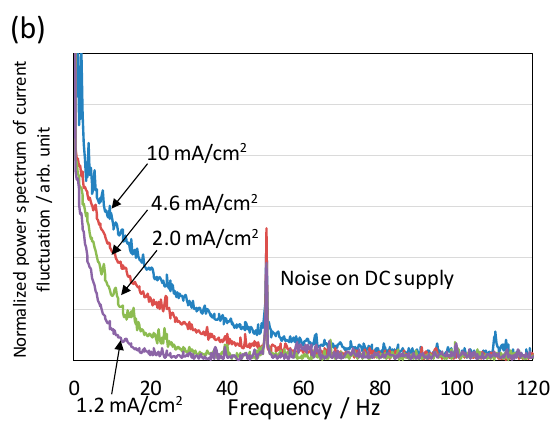
Figure 5. Distributions of ( a ) FE current fluctuation and ( b ) spectrum of the FE current fluctuation obtained by the Fourier transform method.